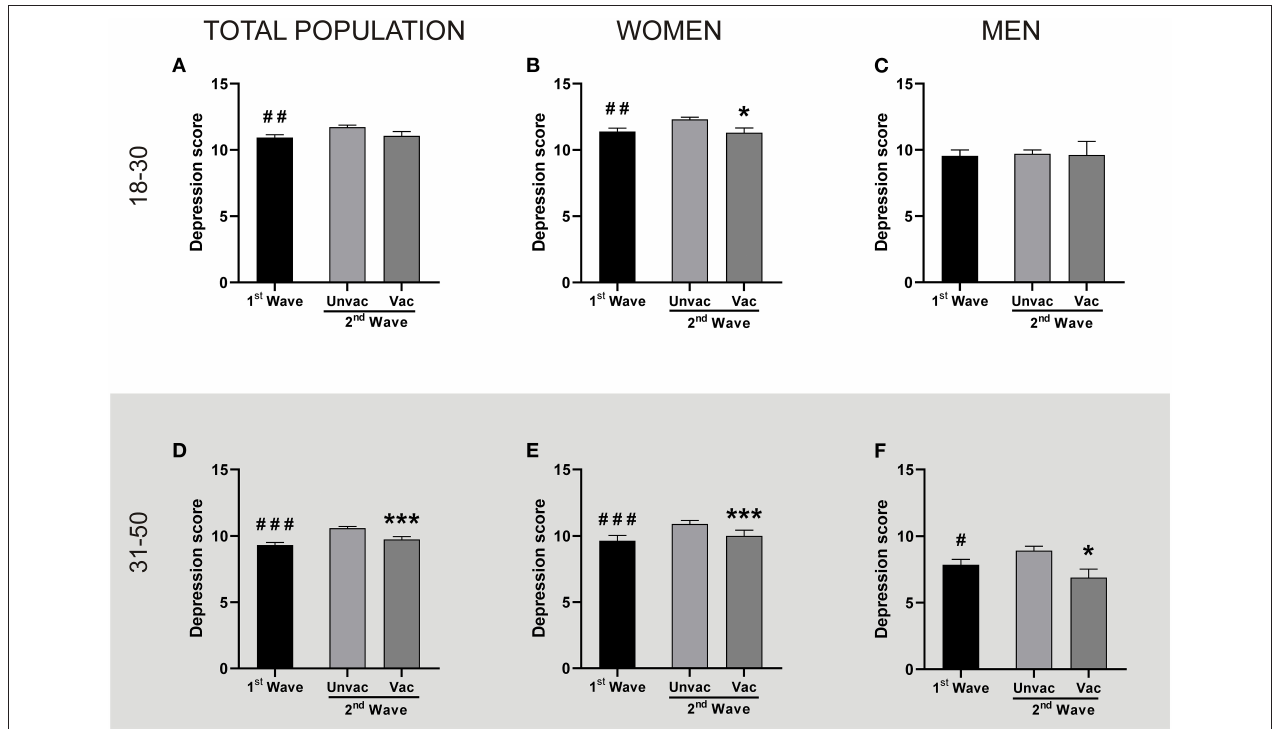
FIGURE 4 | Vaccination was associated with lower depression levels in adult people and young adult women. Each panel compares the Depression levels reported by the unvaccinated people during the 1st and the 2nd wave, and also the same parameter between unvaccinated and vaccinated people within the 2nd wave, by two independent Mann-Whitney U -test. The descriptive statistics are reported in Supplementary Table 4 . Top panel: People aged between 18 and 30. (A) Total population: ## p < 0.01 1st Wave ( n = 685) vs. Unvaccinated ( n = 1,538); Cohen’s d = 0.13. Vaccinated ( n = 303). (B) Women: ## p < 0.01 and * p < 0.05 vs. Unvaccinated; Cohen’s d = 0.16 and 0.17 respectively (1st wave n = 514; unvaccinated n = 1,195; vaccinated n = 259). (C) Men: ( n = 171; 343; 44, for 1st wave, unvaccinated and vaccinated, respectively). Bottom panel: People aged between 31 and 50. (D) Total population: ### p < 0.001 and *** p < 0,001 vs. unvaccinated; Cohen’s d = 0.22 and 0.15 respectively (1st wave n = 846; unvaccinated n = 2,035; vaccinated n = 692). (E) Women: ### p < 0.001 and *** p < 0.001 vs. unvaccinated; Cohen’s d = 0.23 and 0.16 respectively (1st wave n = 700; unvaccinated n = 1,709; vaccinated n = 633). (F) Men: # p < 0.05 and * p < 0.05 vs. unvaccinated; Cohen’s d = 0.20 and 0.38 respectively (1st wave n = 146; unvaccinated n = 326; vaccinated n =